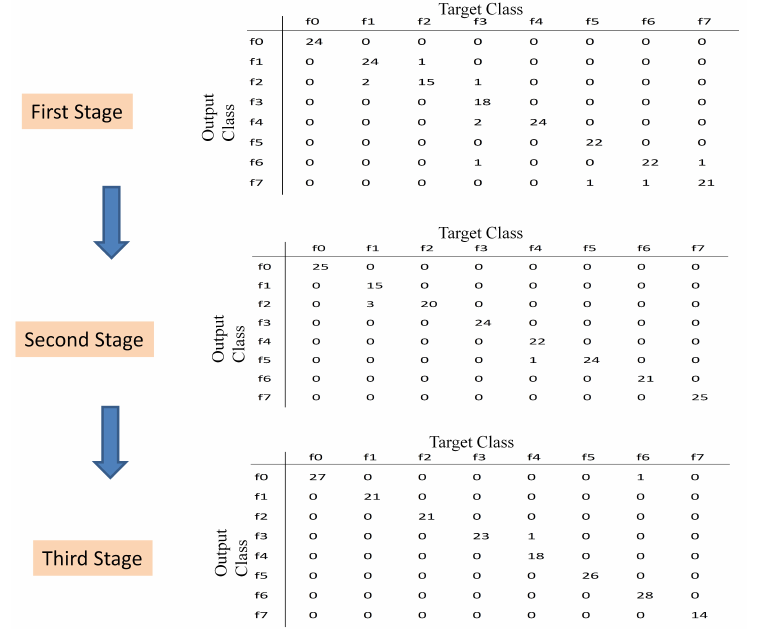
Figure 10. Confusion matrix for the test set, at each